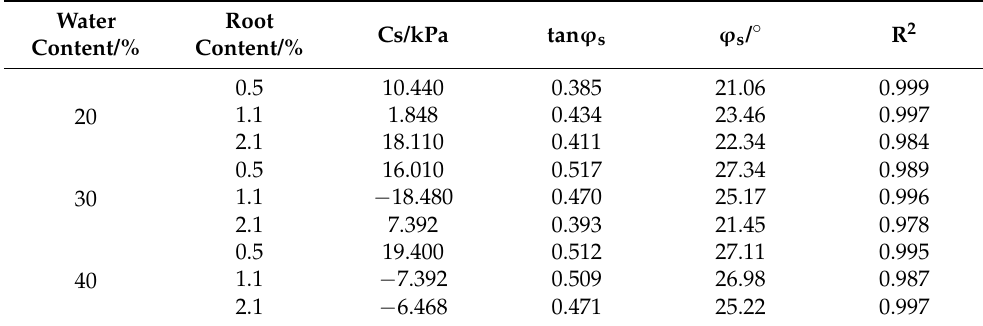
Table 8. Coefficient table of fitted equations with different moisture contents and root contents at the same volume weight.